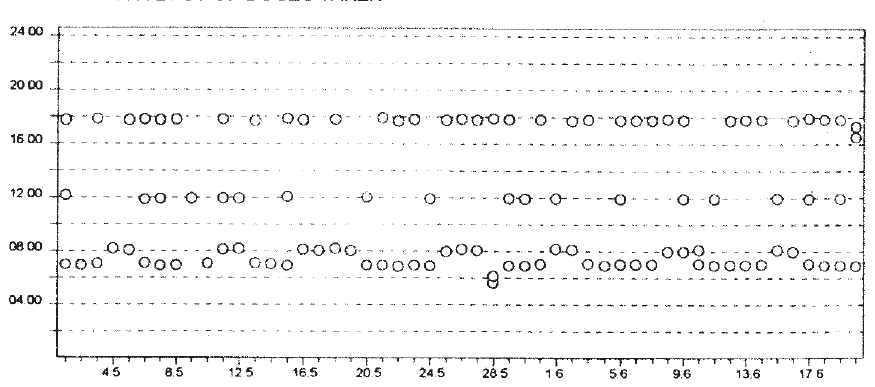
Chronology of doses taken (example of patient No.